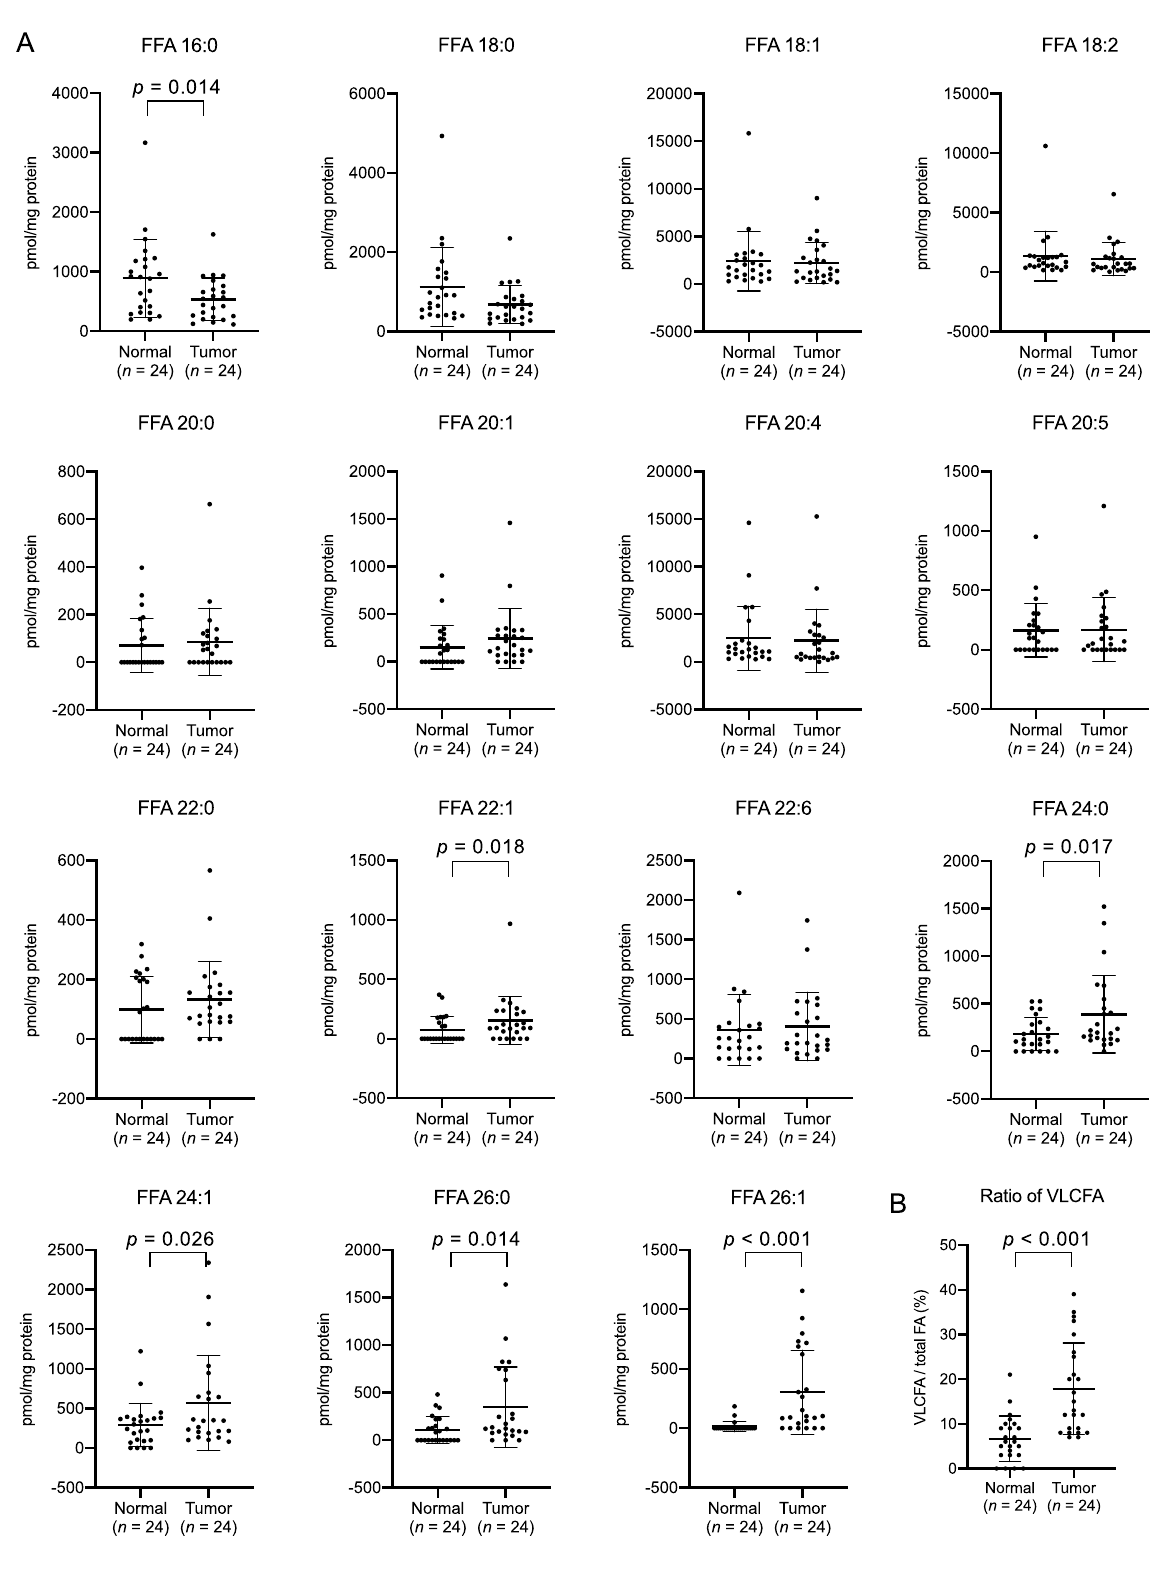
Figure 1. Quantities of nonesterified fatty acid (free fatty acid, FFA) species in the colorectal cancer (CRC) tissues. Each FFA species ( A ) and the portion of nonesterified VLCFA ( B ) was analyzed using LC–MS. All of the nonesterified VLCFA comprising FFA 24:0, FFA 24:1, FFA 26:0 and FFA 26:1 were accumulated in CRC tissues. Data represent the mean ± SD. Statistical analysis was performed using the two-tailed paired t -test in (A and